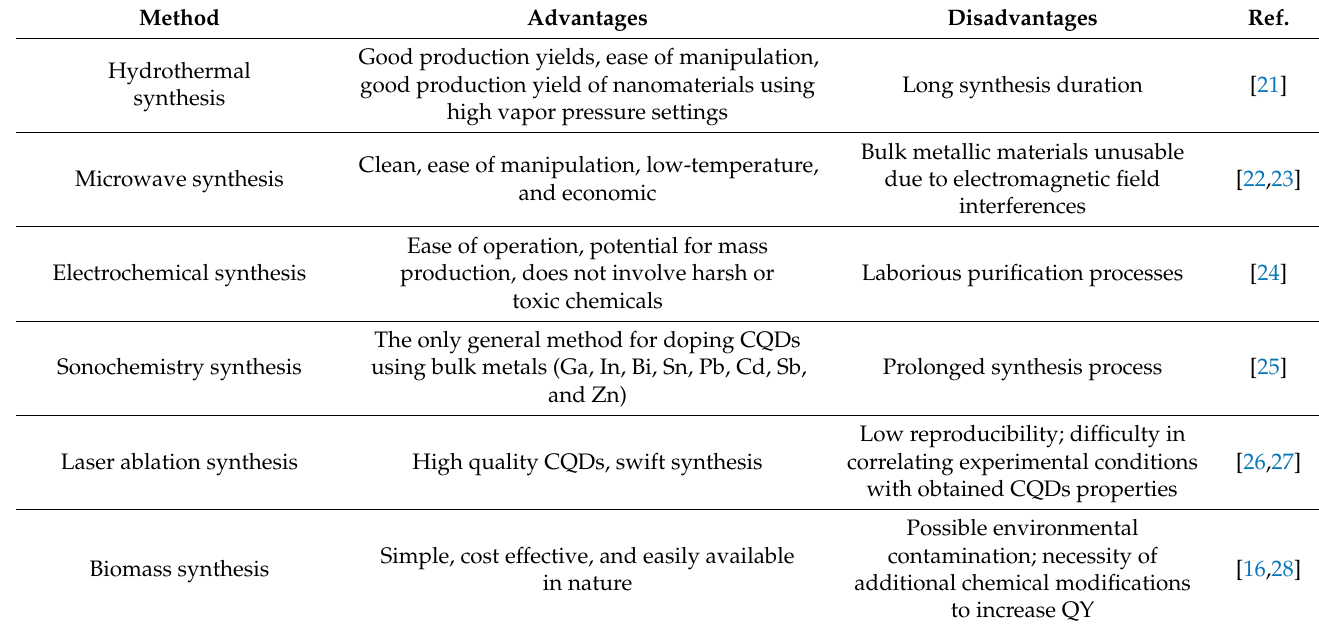
Table 2. Advantages and disadvantages for the most common CQDs synthesis methods.